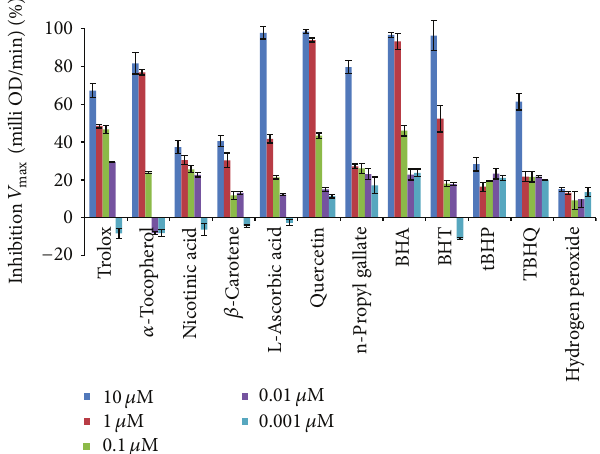
Figure 4. Defined by the data within the reduction limits, plots are treated as a series of trapezoids with vertices at successive data points and at the 𝑥 -axis coordinates of the data points. The areas defined by each of the trapezoids are then computed and summed. Order was found to be trolox > tBHP > BHT. Figure 5 signifies the percent slope (rate) of the time-dependent kinetics with respect to control. The slope reduction option determines the slope of the combined plot using all visible time points in the reduction window. Slope is the same as 𝑉 max rate when 𝑉 max rate is set to the same number of points as the run but is different if we have modified 𝑉